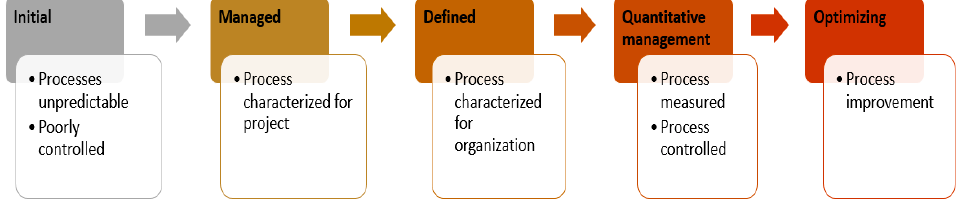
Figure 2. Capability maturity model integration (CMMI) [1,4,30].